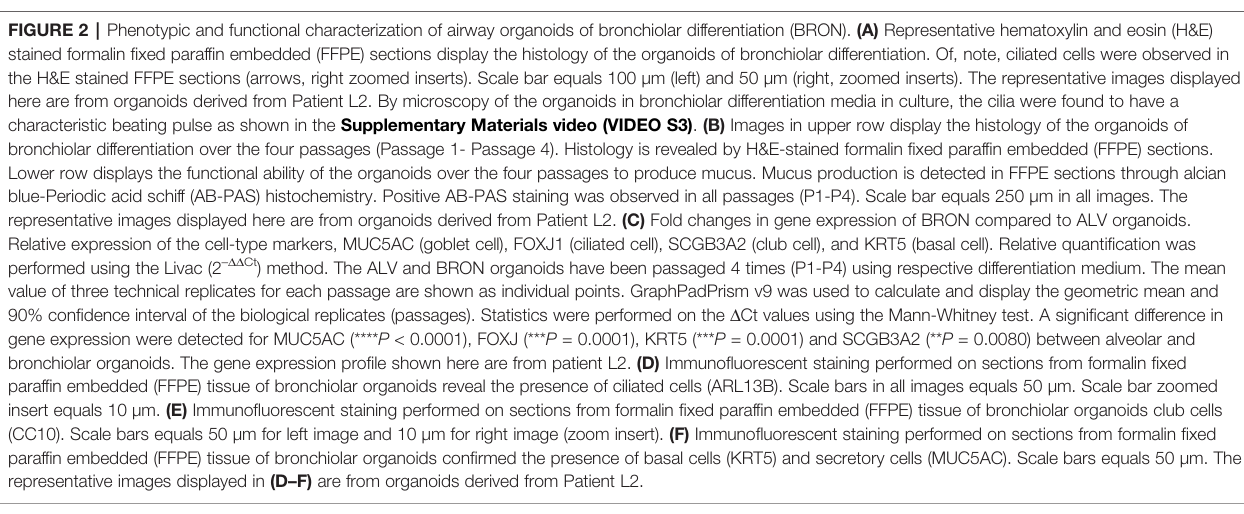
populations, including ciliated cells (ARL13B positive) ( Figure 2D ), club cells (CC10 positive) ( Figure 2E ), goblet cells (MUC5AC positive), and basal cells (KRT5 positive) ( Figure 2F ) were detected in the bronchiolar organoids. The protein-markers, PDPN and SFTPC, which are expected to be expressed in the two main cell types of lung alveoli, namely AT1 and AT2 cells, were detected in moderate levels of expression in bronchiolar organoids. However, the AT2 marker, SFTPC, was not detected in passages 3 and 4 by RT-qPCR (data not shown). Taken, together these results con fi rm that the applied bronchiolar differentiation protocol induced a representative model of the conducting airway epithelium, with the histoarchitecture, functional abilities, and RNA and protein markers of the various cell types of the tissue expressed as expected.